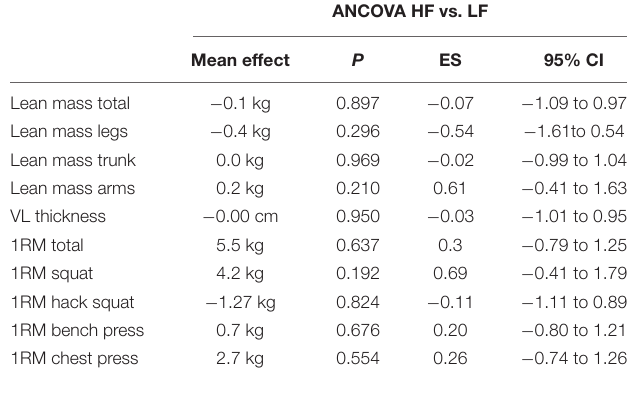
ANCOVA HF vs. LF